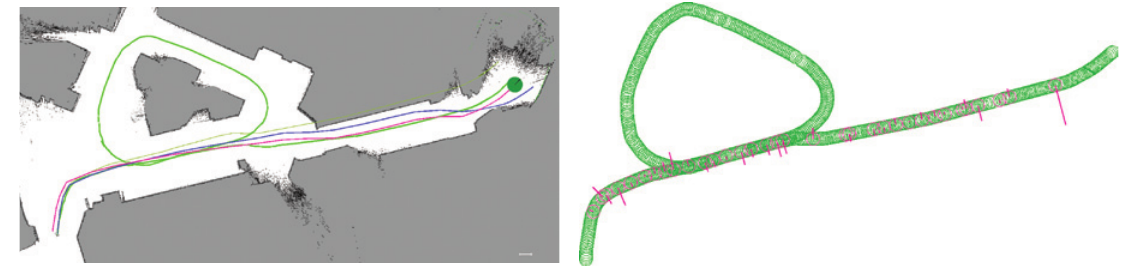
Figure 13. Example of Vision-Based Path Following. Green circles represent learned places, and magenta circles show the loop-closure locations detected during the navigation. The line in the middle of the magenta circles corresponds to the x -axis translation computed from the matching images.